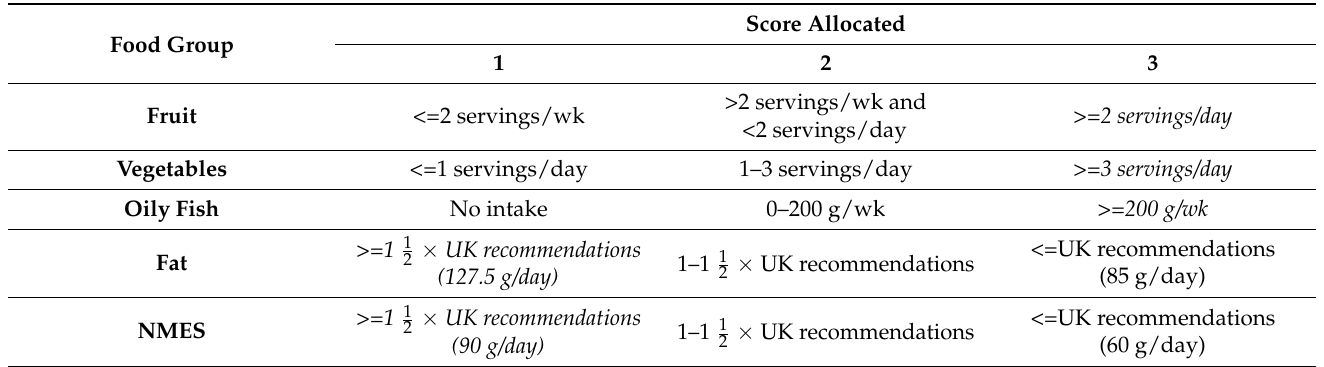
Table 1. DANTE score allocation per food group (Cleghorn and Cade,